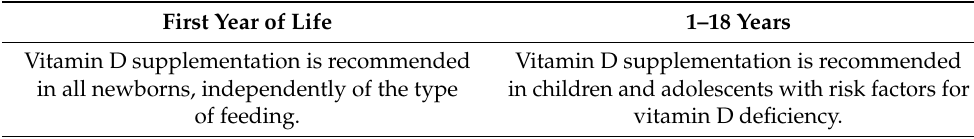
Table 3. Key points of vitamin D supplementation in childhood